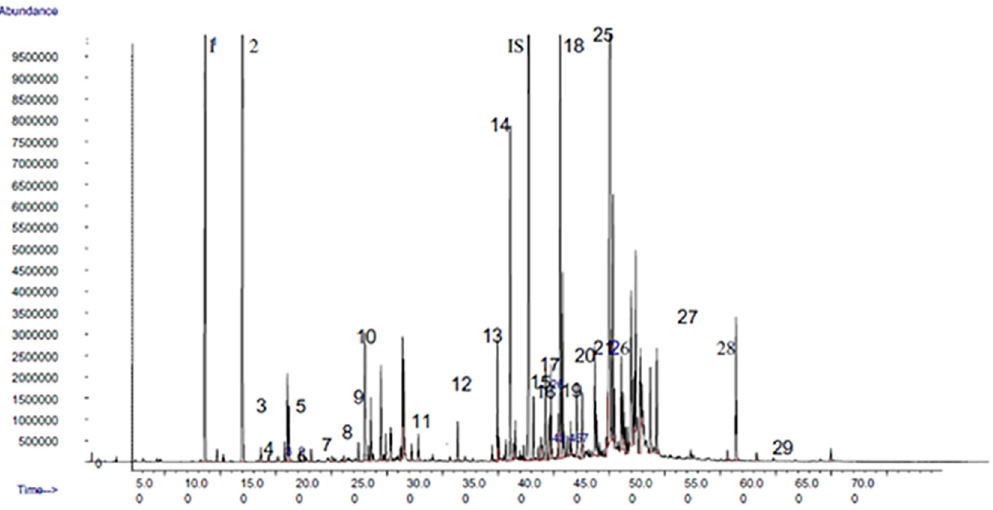
Figure 5: GC - MS analysis of walnut